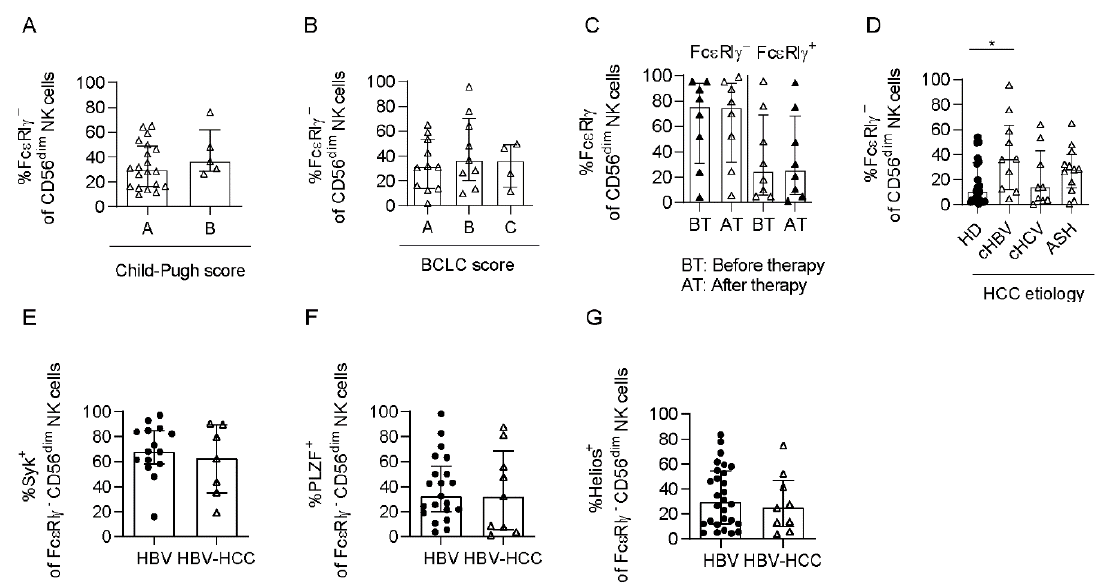
Figure 6. Expansion of Fc ε RI γ − adaptive NK cells in HBV-associated HCMV+ HCC patients. Frequency of Fc ε RI γ − adaptive NK cells in HCC patients depending on Child scores ( A ) ( n = 20 for Child A, n = 5 for Child B), BCLC scores ( B ) ( n = 11 for BCLC A, n = 9 for BCLC B, n = 4 for BCLC C) HCC therapy ( C ) ( n = 8), and underlying HCC etiology ( D ) (HD n = 21, cHBV HCC n = 10, cHCV HCC n = 9, ASH HCC n = 12). Syk ( E ), PLZF ( F ) and Helios ( G ) expression on Fc ε RI γ − adaptive CD56 dim NK cells in HCMV + HBV infected patients ( n = 15 in ( E ), n = 21 in ( F ), n = 28 in ( G )) and HCMV + HBV-associated HCC patients ( n = 7 in ( E ), n = 9 in ( F , G )). Each dot represents an HCMV + individual with more than 10% adaptive Fc ε RI γ − CD56 dim NK cells. Bars indicate median with IQR. The following statistical analyses were performed: unpaired, two-tailed Mann–Whitney test ( A , E – G ), Kruskal–Wallis test ( B , D ), paired two-tailed Wilcoxon Test ( C ). ASH: alcohol-induced steatohepatitis, AT: after therapy, BT: before therapy, HBV: hepatitis B virus, HBV-HCC: HBV-associated HCC patients, HCC: patients with hepatocellular carcinoma, HCMV: human cytomegalovirus, HCV: hepatitis C virus, HD: healthy donors. *: p < 0.05.